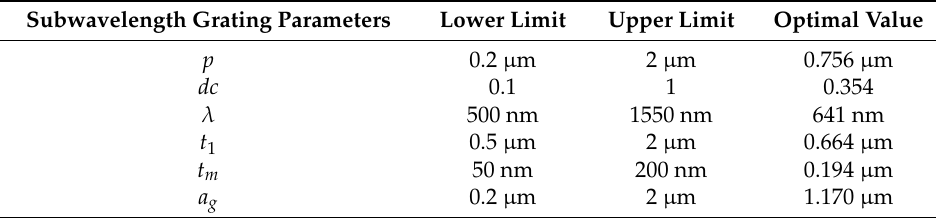
Table 1. Optimization interval and optimal values of the optical readout parameters.